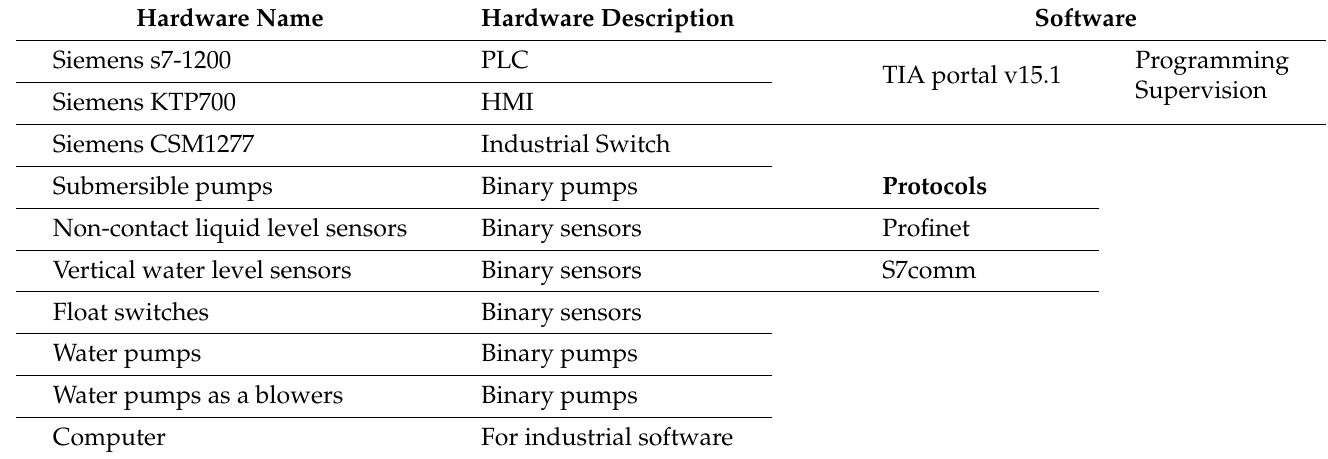
Table 4. Components of wastewater treatment